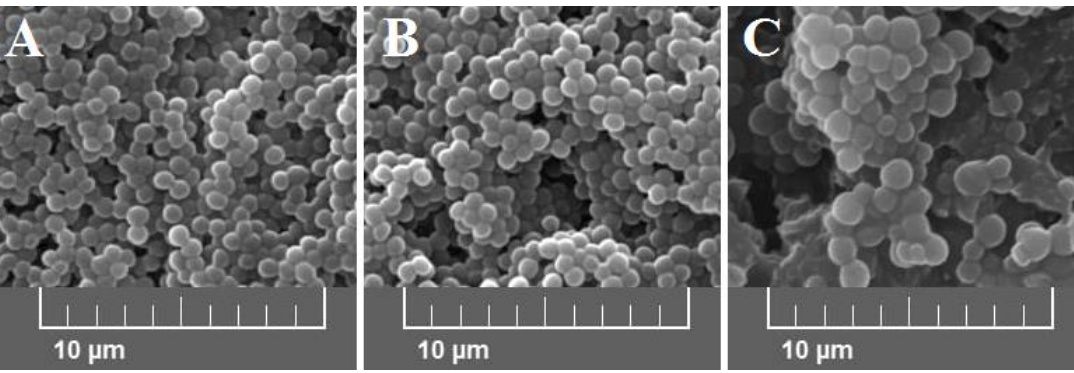
Figure 3. Scanning electron microscope (SEM) images at 5.00 kx of S. aureus Newman strain isolated from different modifications of the Mueller-Hinton agar: non-supplemented (control medium A); supplemented with 1% ( v/v ) Tween 80 (medium B); supplemented with 1% ( v/v ) Tween 80 and trans -anethole at subinhibitory concentration — MIC 50 (medium C).